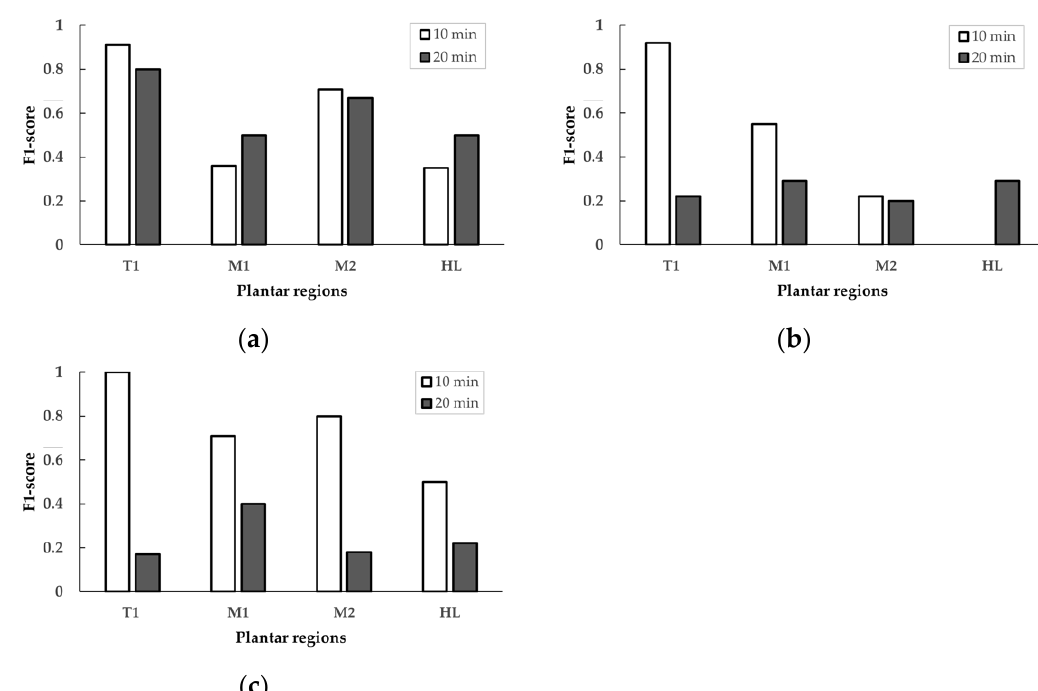
Figure 5. Comparison of F1-scores on walking duration (10 min and 20 min) in the four plantar regions at walking speed ( a ) 0.8 m/s, ( b ) 1.6 m/s, and ( c ) 2.4 m/s. T1, first toe; M1, first metatarsal head; M2, second metatarsal head; HL, heel. Table 2. Effect of walking duration on the F1-score in four plantar regions. F1-Score of Walking Walking Speed Plantar Region